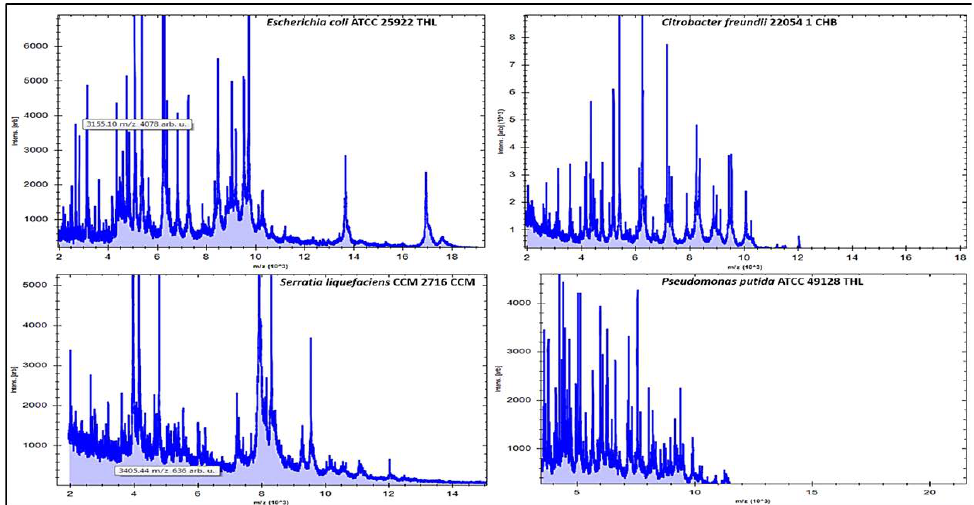
Fig. 4. MBT mass spectra of some overnight cultured gram-negative bacteria ( Escherichia coli, Citrobacter freundii, Srratia liquefaciens and Pseudomonas putida ) isolated from air samples